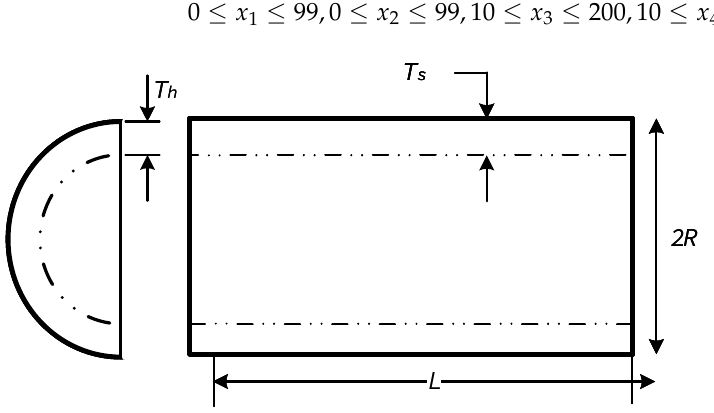
Figure 5. Pressure vessel design problem.